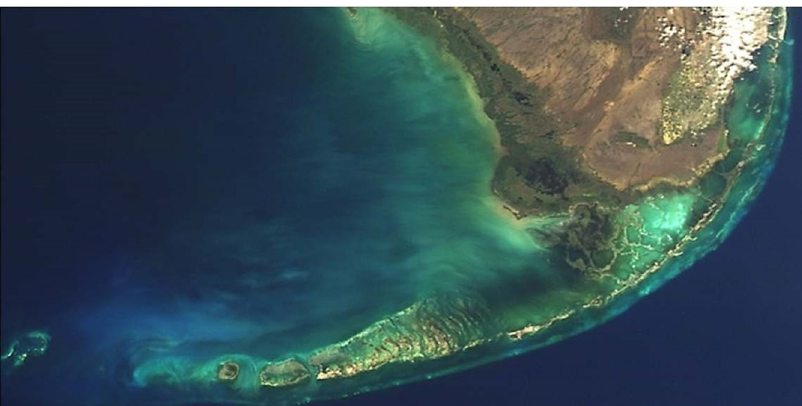
Fig. 1 Satellite image of the Florida Keys island chain. The cover percentage of the bank reef located off the coast of the island chain has steadily declined in recent decades. Climate change, coral disease, and a decline in the overall water quality are factors that affected the decline. Image Credit: